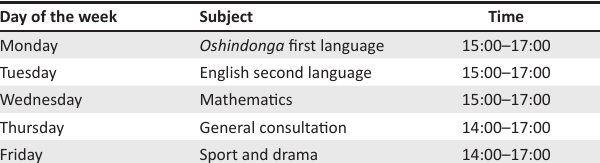
TABLE 1: Remedial support